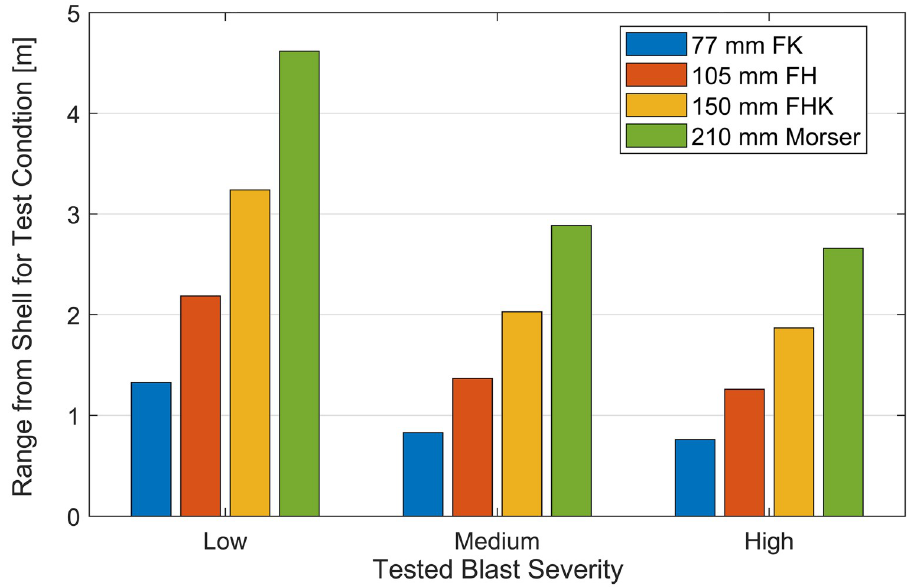
Fig 6. Equivalent distance to WWI shell explosions. Distance from a WWI German shell explosion to experience blast conditions tested in this study. Pressure measurements from bare head testing conditions were used to calculate these